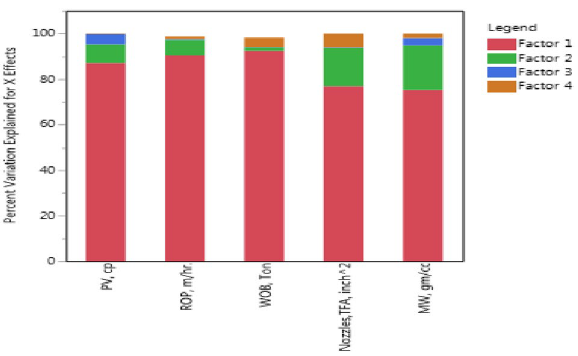
Fig. 19 Correlation loading plot of ECD model